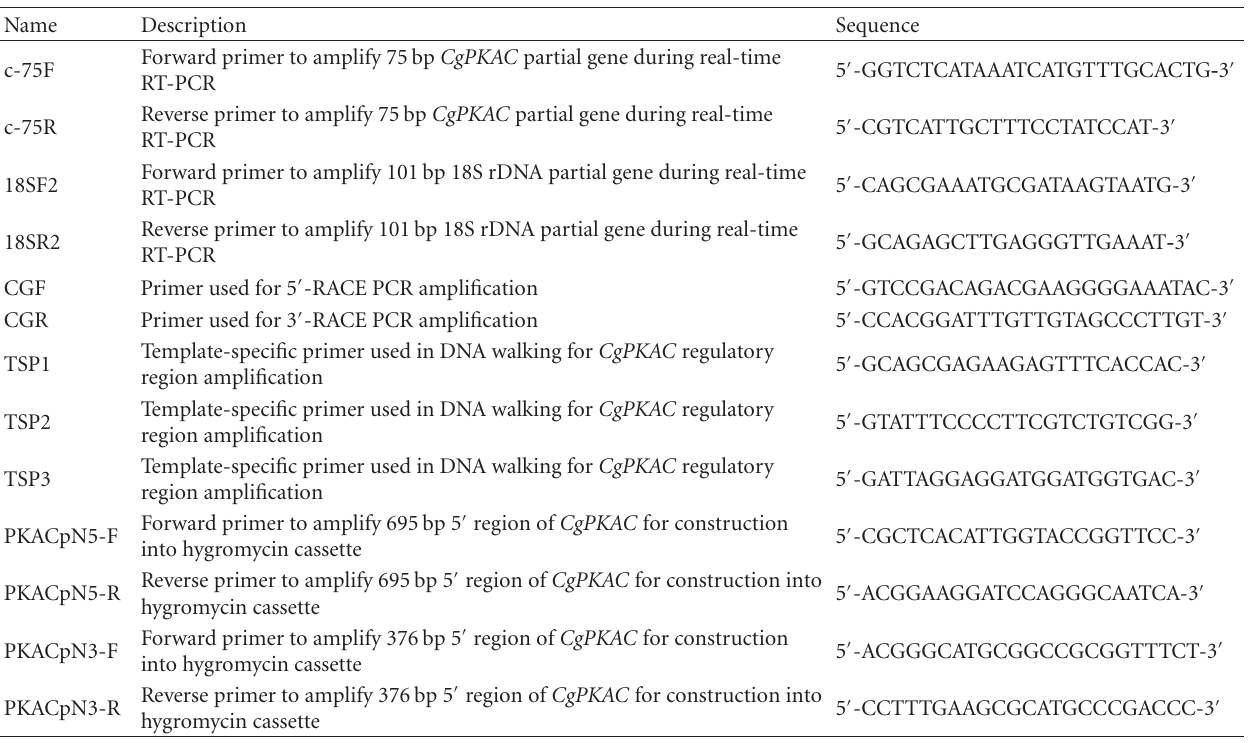
Table 1: Oligonucleotide primers used in this